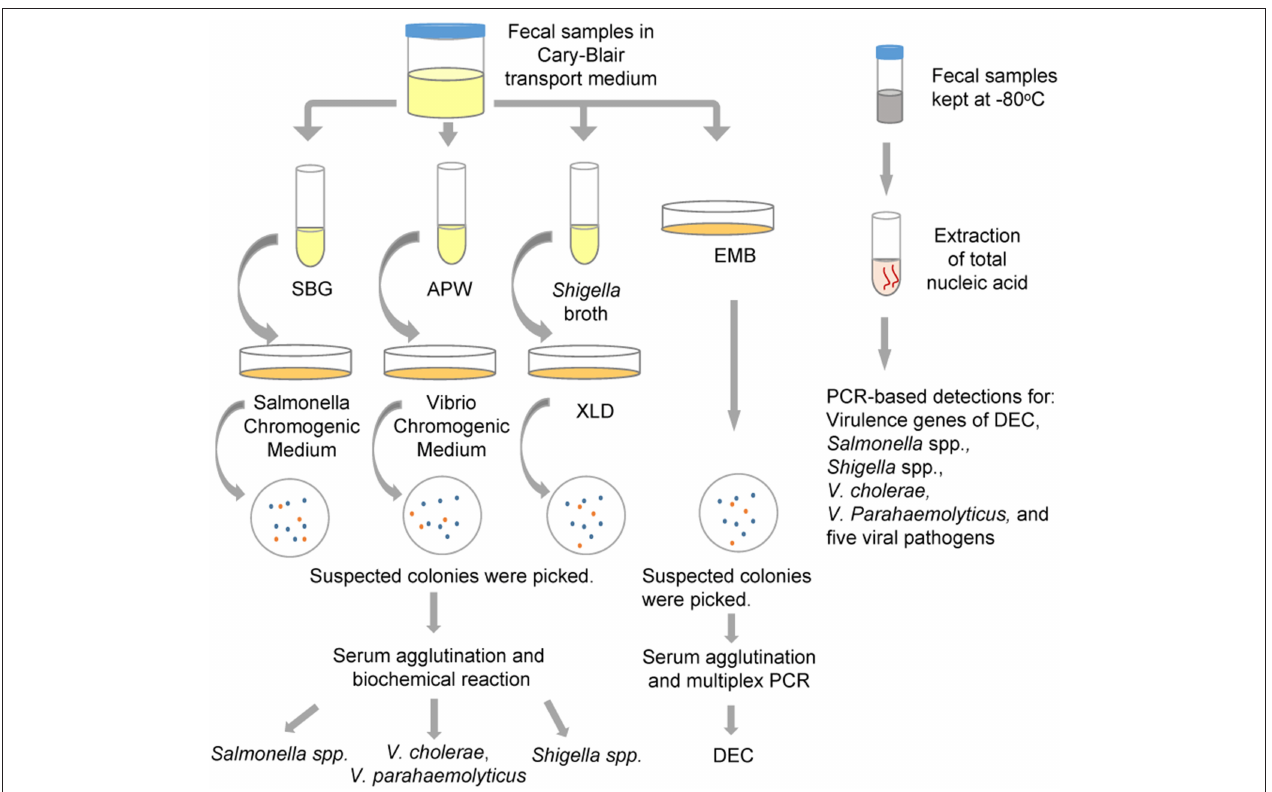
FIGURE 1 | The protocol for multiple pathogen detection used in the study. APW, Alkaline Peptone Water; DEC, diarrheagenic Escherichia coli ; EMB, Eosin Methylene Blue agar; SBG, Selenite Brilliant Green Broth; XLD, Xylose Lysine Deoxycholate